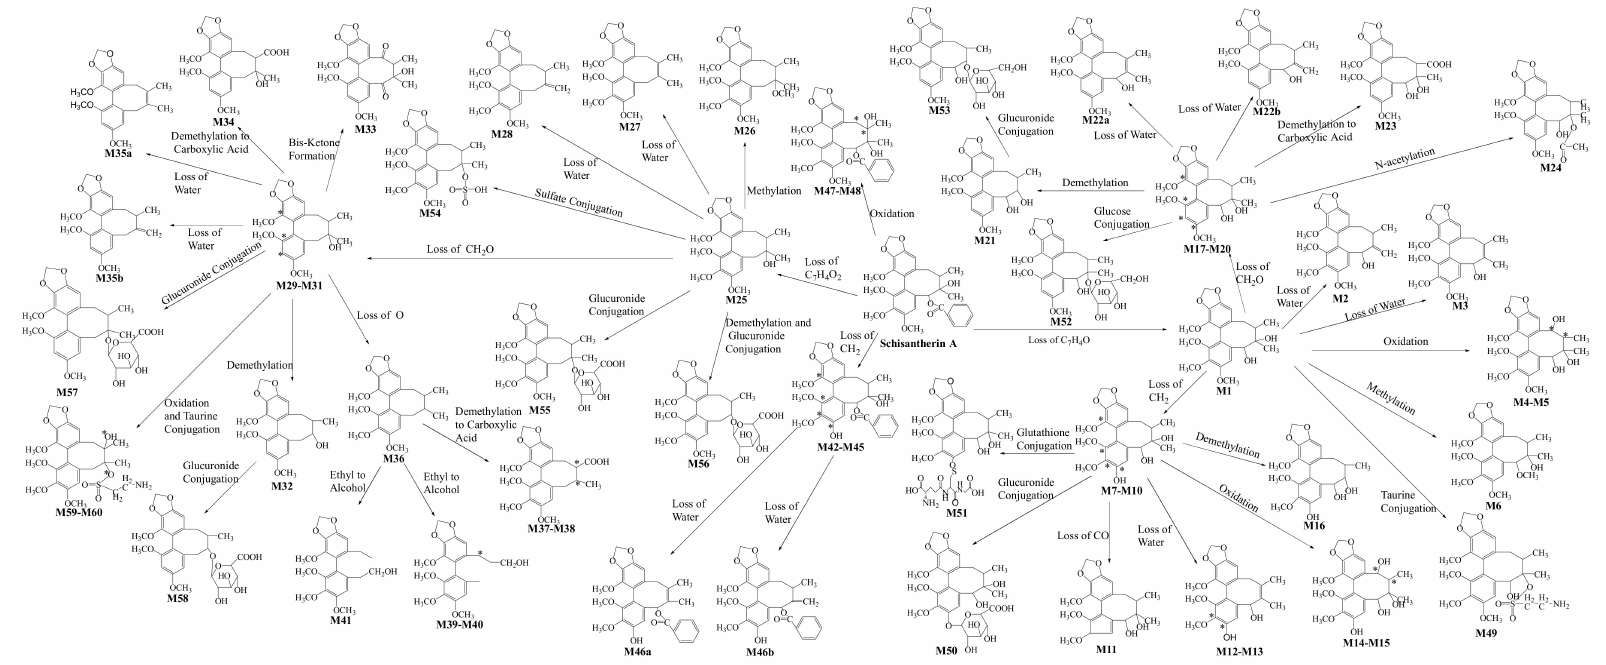
Figure 4. Proposed major metabolic pathway of Schisantherin A in a rat